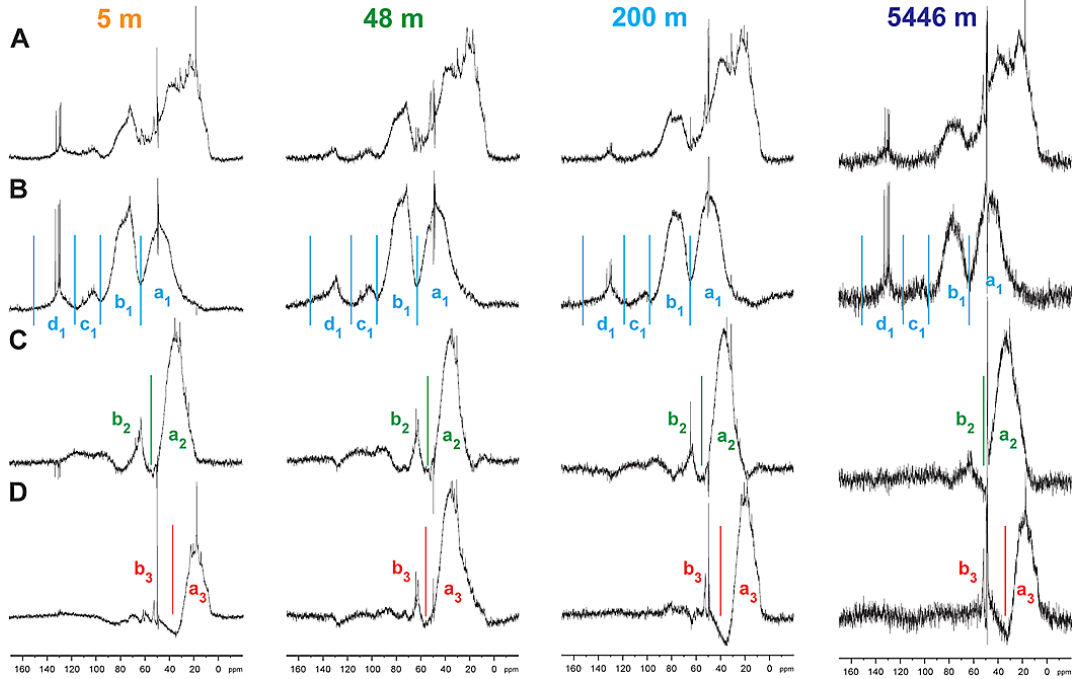
Fig. 4. 13 CNMR spectra for marine SPE-DOM obtained by solid phase extraction (PPL) at different depths (from left to right). (A) Su- perimposed protonated carbon NMR resonances (CH 123 ; DEPT − 45 13 C NMR spectra); multiplicity-edited 13 C NMR spectra are (B) CH: methine, with indices a 1 –d 1 denoting the following chemical environments: HC ar -C/O- HC -O/ HC -O/ HC -C; (C) CH 2 : methylene, with in- dices a 2 and b 2 denoting the following chemical environments: H 2 C -O/ H 2 C -C; and (D) CH 3 : methyl, with indices a 3 and b 3 denoting the following chemical environments : H 3 C -O/ H 3 C -C. The respective NMR section integrals are provided in Table